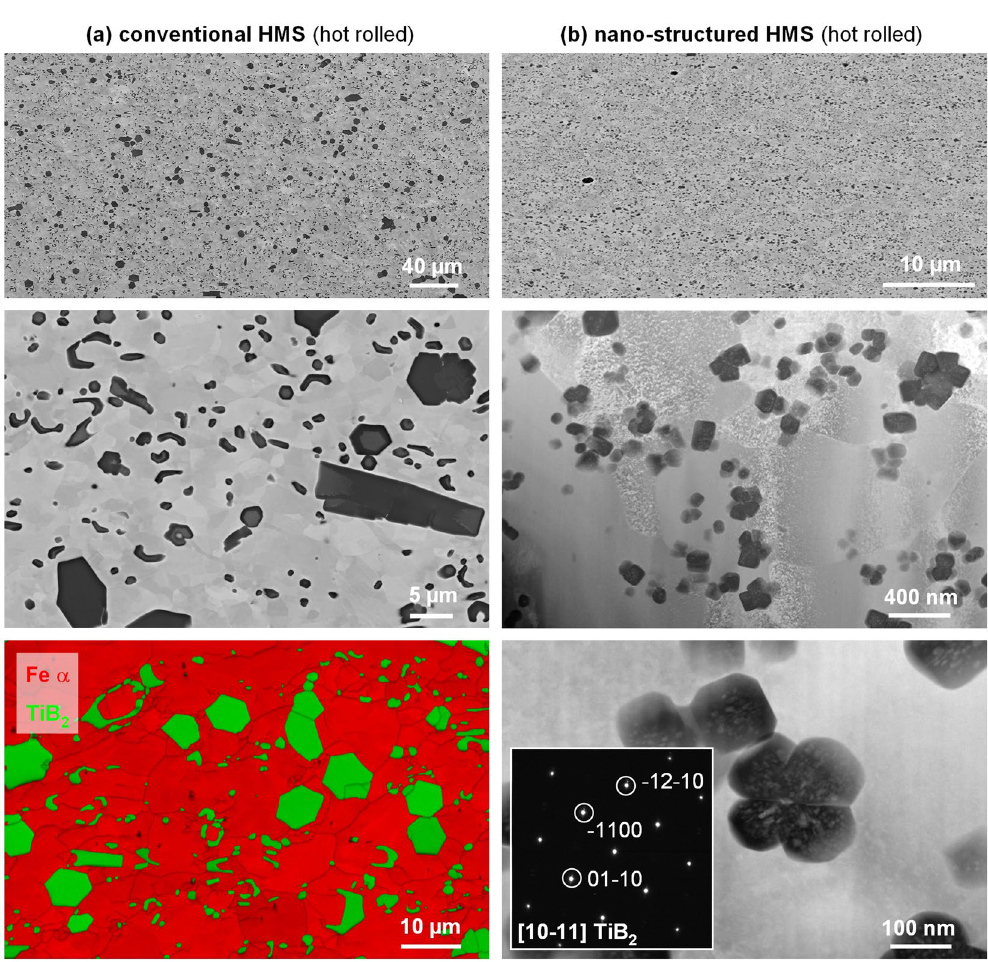
Figure 4. Microstructure characterisation results as SEM BSE / EBSD and STEM DF images of High Modulus Steels after hot rolling for ( a ) conventional casting and ( b ) spray-forming. The effective nano-structuring of both particles and matrix through spray-forming is